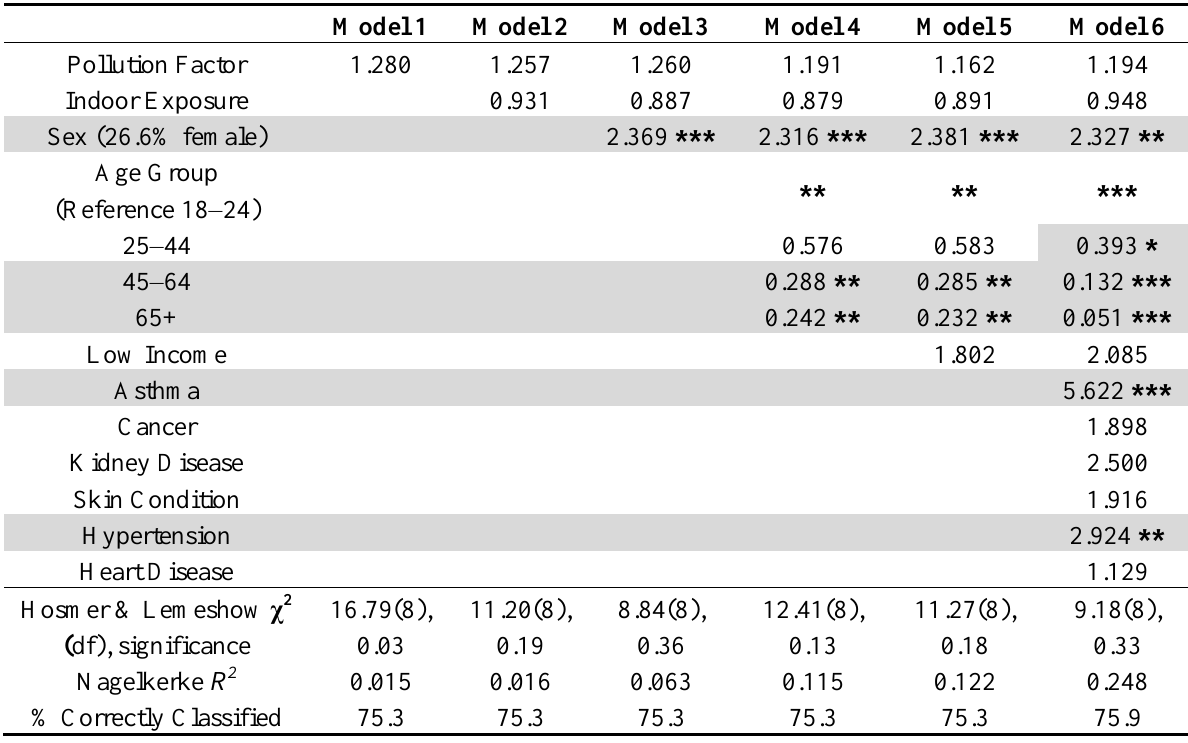
Table 4. Odds ratios for 5+ cardinal symptoms—occupational exposure (n =